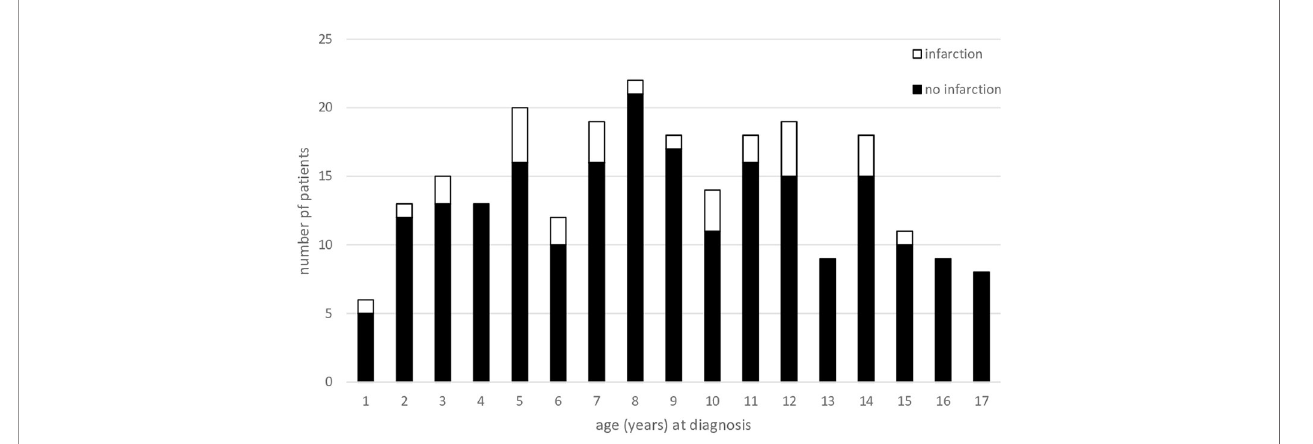
FIGURE 2 | Age of 244 patients (recruited in KRANIOPHARYNGEOM 2007 between 2007 and 2019) at the time of primary surgery/diagnosis of adamantinomatous, childhood-onset craniopharyngioma. Patients presenting with cerebral infarction (CI) are represented by open parts of columns; patients without CI are depicted as solid black parts of